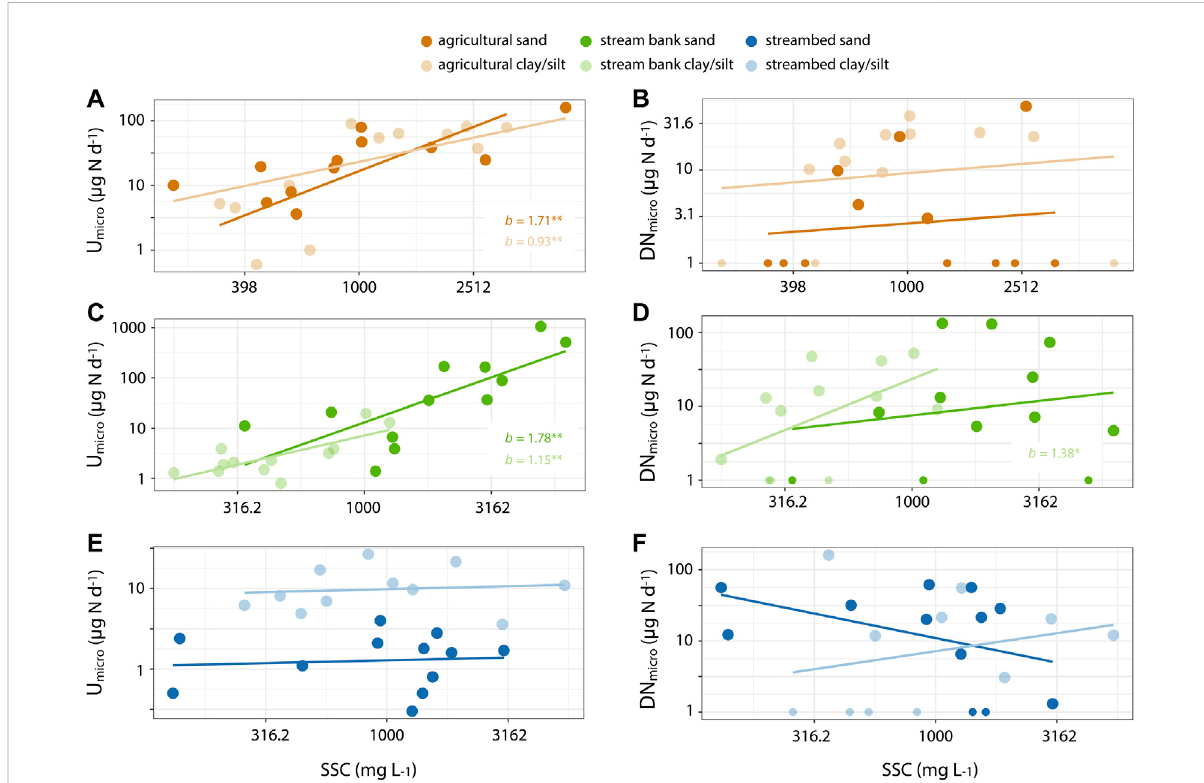
FIGURE 5 Log-log relationships between suspended sediment concentration (SSC) and microcosm-speci fi c rates of assimilatory uptake (A,C,E) and denitri fi cation (B,D,F) for each sediment source and size. Color legend is consistent with previous fi gures. Slope values and signi fi cance [(blank) p > 0.05; * p < 0.05; **, p < 0.01; *** p < 0.001] are indicated in each